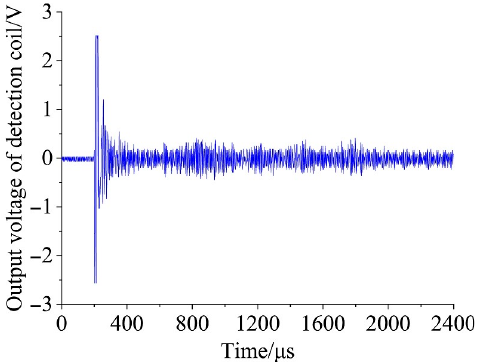
Figure 14. The waveform acquired by the oscilloscope when the magnetic field coil is not conducted. The signal waves with peaks above 1 V in the figure show the pulse wave and the initial echo. The pulsed wave is caused by changes in the magnetic field when the waveguide wire conducts a pulsed current. The initial echo within 100 µs after the pulse wave is caused by the initial torque wave generated by the waveguide wire at the signal line connection position after the pulse current is applied.